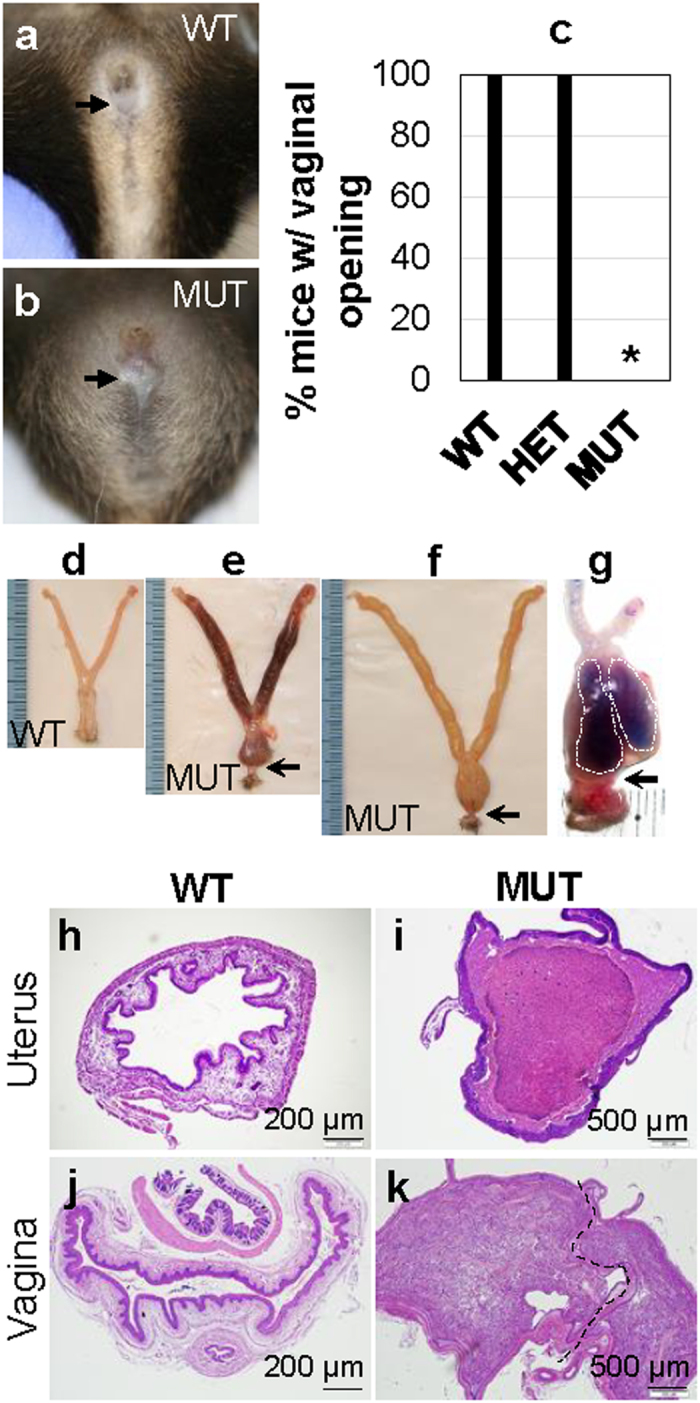
Imperforate vagina in Lhfpl2 mutant (MUT) mice.(a,b) Representative pictures of WT (a) and MUT (b) mice at 8-week old. (c) Percentage of mice with vaginal opening. *P < 0.05. N = 18, 26 and 35 for WT, HET and MUT, respectively. (d–f) Representative reproductive tracts of WT (d) and MUT females (e,f) at 8-week old. (g) A MUT vagina showing two chambers (white dotted lines) by blue dye infusion. (h) Histology of a WT uterus. (i) Histology of a MUT uterus. (j) Histology of a WT vagina. (k) Histology of a MUT vagina. Dotted black line in (k), vaginal septum; black arrow, the position of vagina opening (a,b) or the position of vagina atresia (e–g); scale bar, 200 μm (h,j) or 500 μm (i,k).